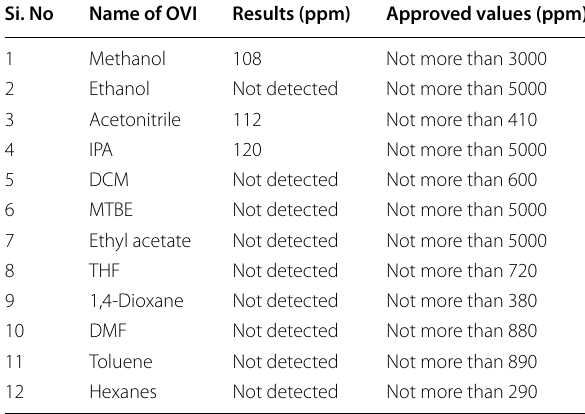
Table 11 Data for Oseltamivir phosphate tablet analysis Si.